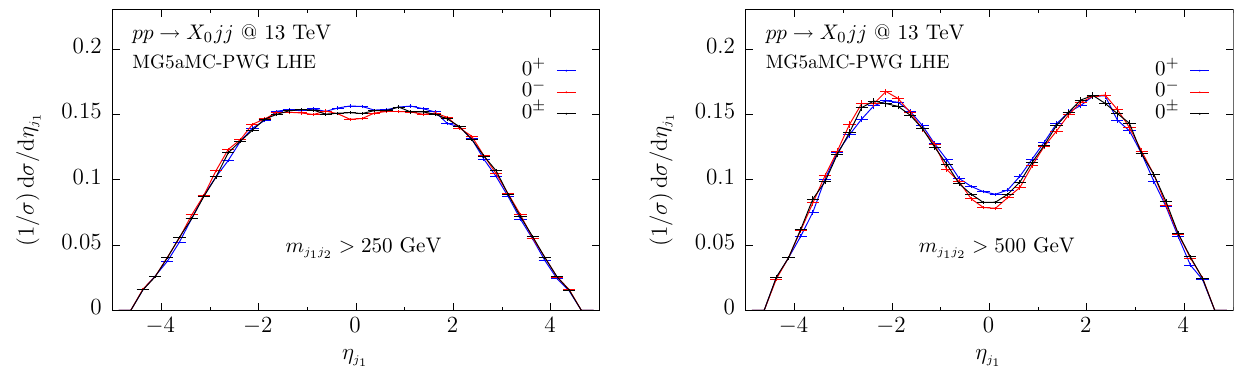
Fig. 5 Normalised differential cross section as a function of the pseudorapidity of the leading jet, for the three CP scenarios. On the left panel, a cut of 250 GeV is imposed on the dijet mass, while on the right panel a cut of 500 GeV is applied. The colour code is the same as in Fig. 1